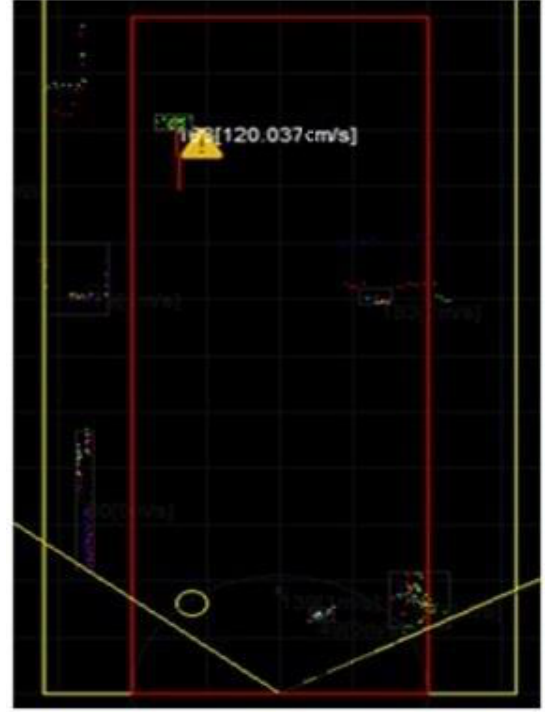
Figure 8. There is an object in danger zone and getting closer to tram slowly. An exclamation mark appears on the screen and an alarm signal is activated. Heading of moving object can be seen with a red line and possible collision position can be seen as a yellow circle on the Figure 8.